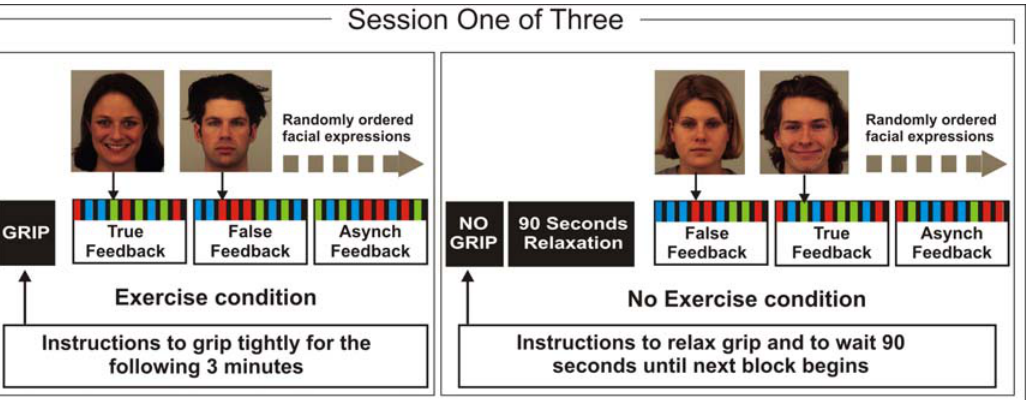
Figure 6. Experimental Paradigm and Task Design. Participants viewed emotional faces (happy, angry & neutral expressions, presented for 2 seconds each) and rated the emotional intensity during a subsequent blank screen (presented for 1 second). Within each of three sessions, participants performed the face rating task during isometric exercise and no exercise conditions (3 minutes each). Within each condition, physiological feedback of cardiac rate was true, asynchronous and false (1 minute each). Each participant completed three scanning